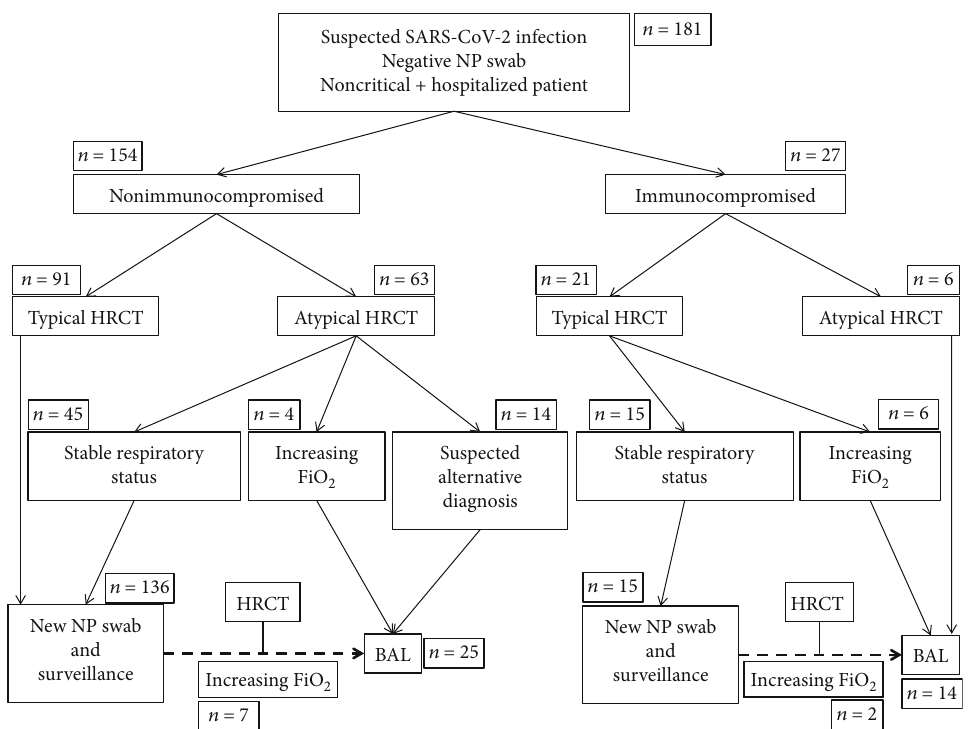
Figure 1: Decisional algorithm followed for indication of bronchoalveolar lavage (BAL) in noncritically ill patients with suspicion of SARS-CoV-2 infection, witha fi rst negative nasopharyngeal (NP) swab. Stable respiratory status means that the patient has no increase of oxygen need in the past 48 hours. Abbreviations: NP — nasopharyngeal; BAL — bronchoalveolar lavage; HRCT — high-resolution chest CT